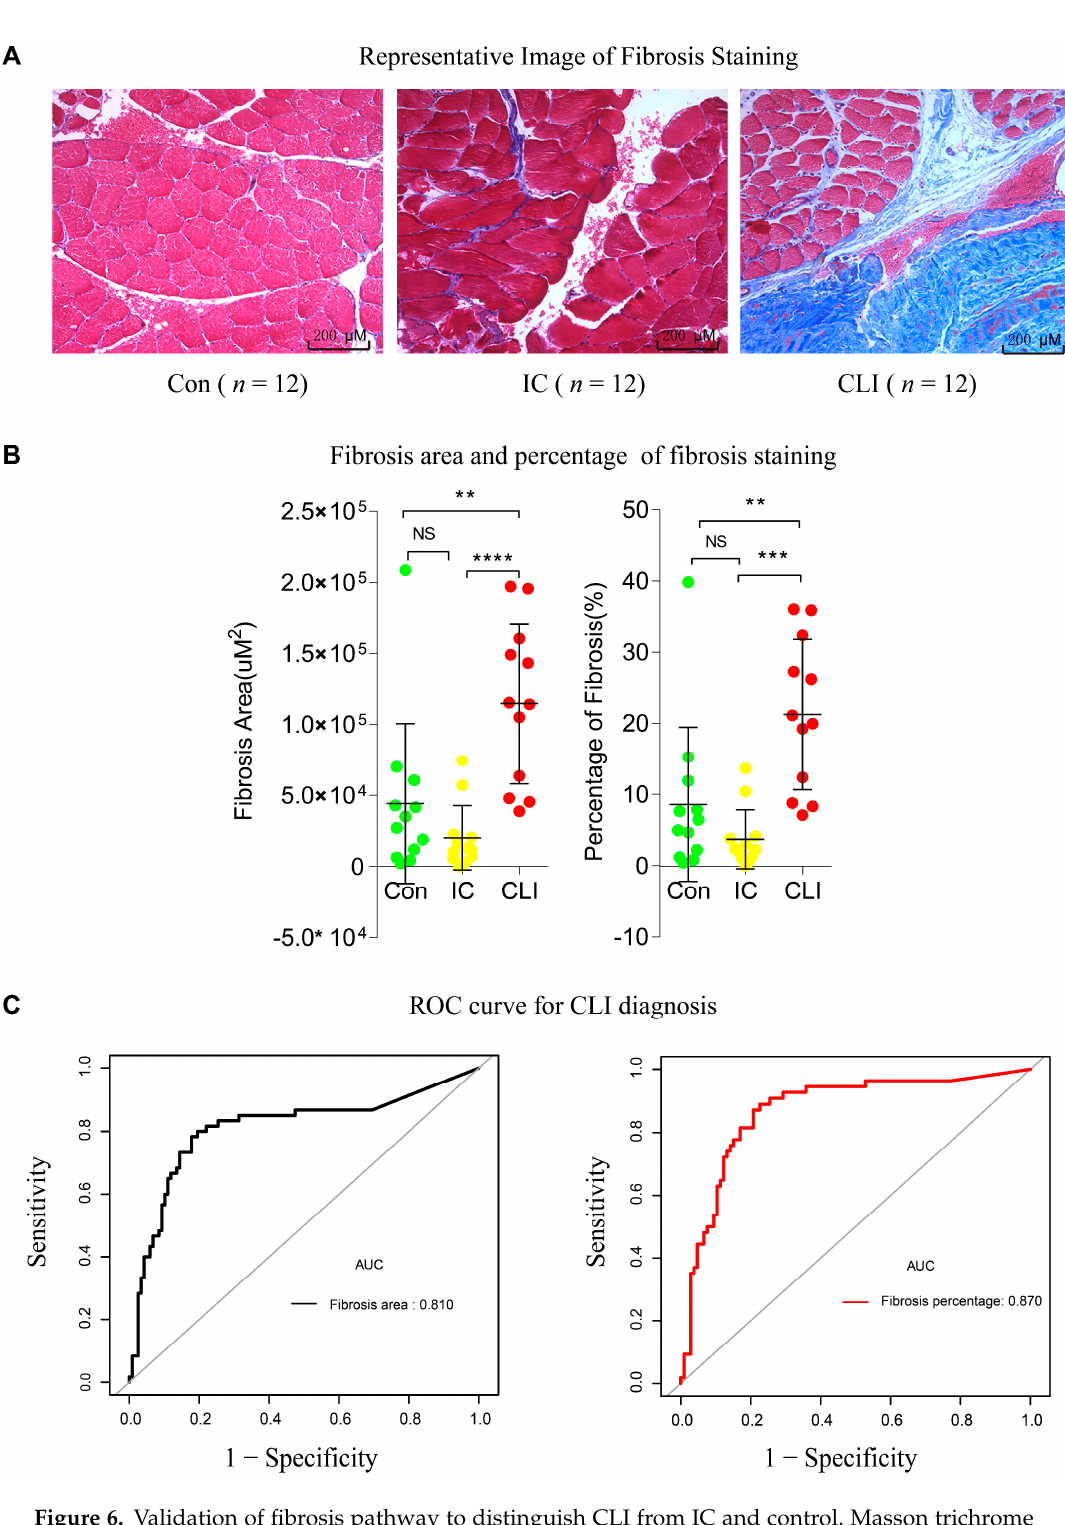
Figure 6. Validation of fibrosis pathway to distinguish CLI from IC and control. Masson trichrome staining of gastrocnemius muscle biopsies. ( A ) Representative fibrosis staining image ( × 20 magnification). ( B ) Assessment of fibrosis by area and percentage. Each dot is a sample. Comparison between HA, IC, and CLI group using single one-way analysis of variance (ANOVA) followed by Bonferroni t-test; ** p < 0.01, *** p < 0.001, **** p < 0.0001. ( C ) ROC for the diagnosis of CLI. Fibrosis area (AUC area = 0.81) and fibrosis percentage (AUC area = 0.87). N = 12 for non-PAD control, IC, and CLI. NS, not